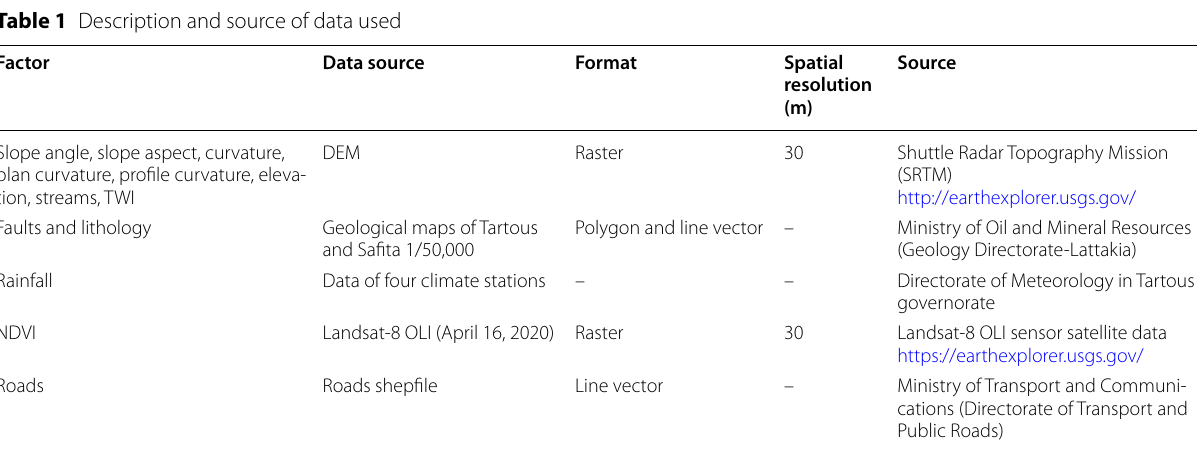
integration between the driving geographical characteris- tics in the study area (Table 2).